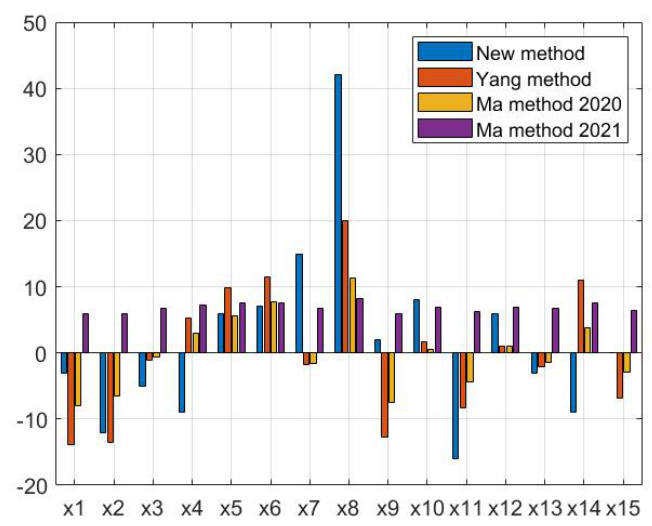
Figure 1. Comparison methods. Figure 1: Comparison methods